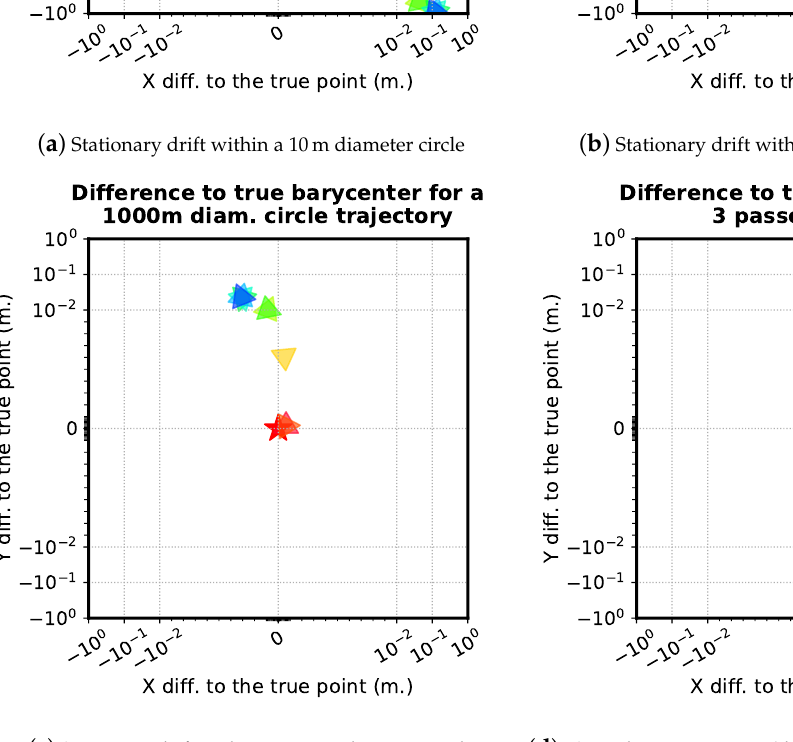
( d ) Straight trajectories (three passes in a 2000 m × 2000m square) Figure 4. Distance to true barycenter (red star) for different inversion protocols for the four trajectories considered. Inversion mode with a result over 10m are not